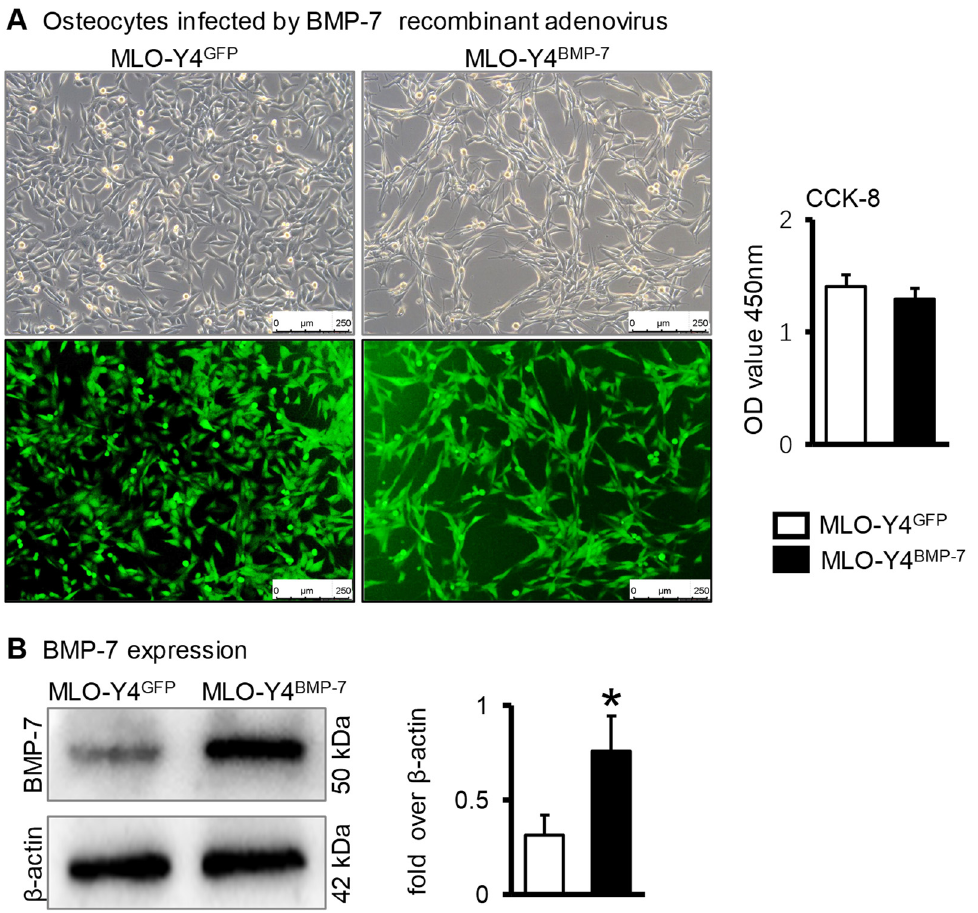
Figure 3. The construction of osteocytes with high expression of BMP-7. ( A ). Fluorescence image and proliferation of MLO-Y4 cells after transfection of Ad-BMP-7. ( B ). Western blotting validated the BMP-7 protein level in MLO-Y4 cells transfected with Ad-BMP-7. * p < 0.05, compared with MLO-Y4 GFP group.